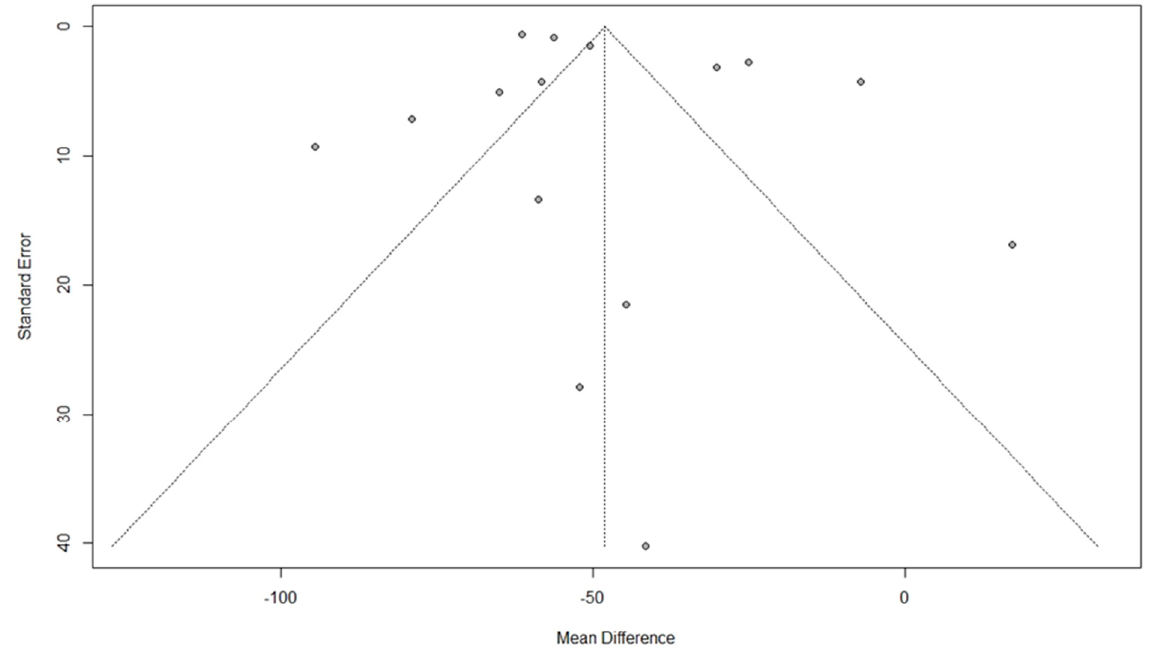
Figure 4. Funnel plot for the results of the effect of surgical intervention (vaginal and abdominal surgery) on total quality of life score using the Pelvic Floor Distress Inventory Questionnaire [PFDI]. Eleven studies used the PFIQ questionnaire to estimate the QoL [9,36,37,40,42,43,45,51,55,56]. The pooled results showed a significant improvement in QoL after surgical interventions (MD: − 33.41, 95% CI: − 43.48 to − 23.34, I2: 99%, p < 0.01) (Figure 5). Visual inspection of the funnel plot and results of Egger’s test for funnel plot asymmetry ( p = 0.52) indicated no possible source of publication bias (Figure 6).